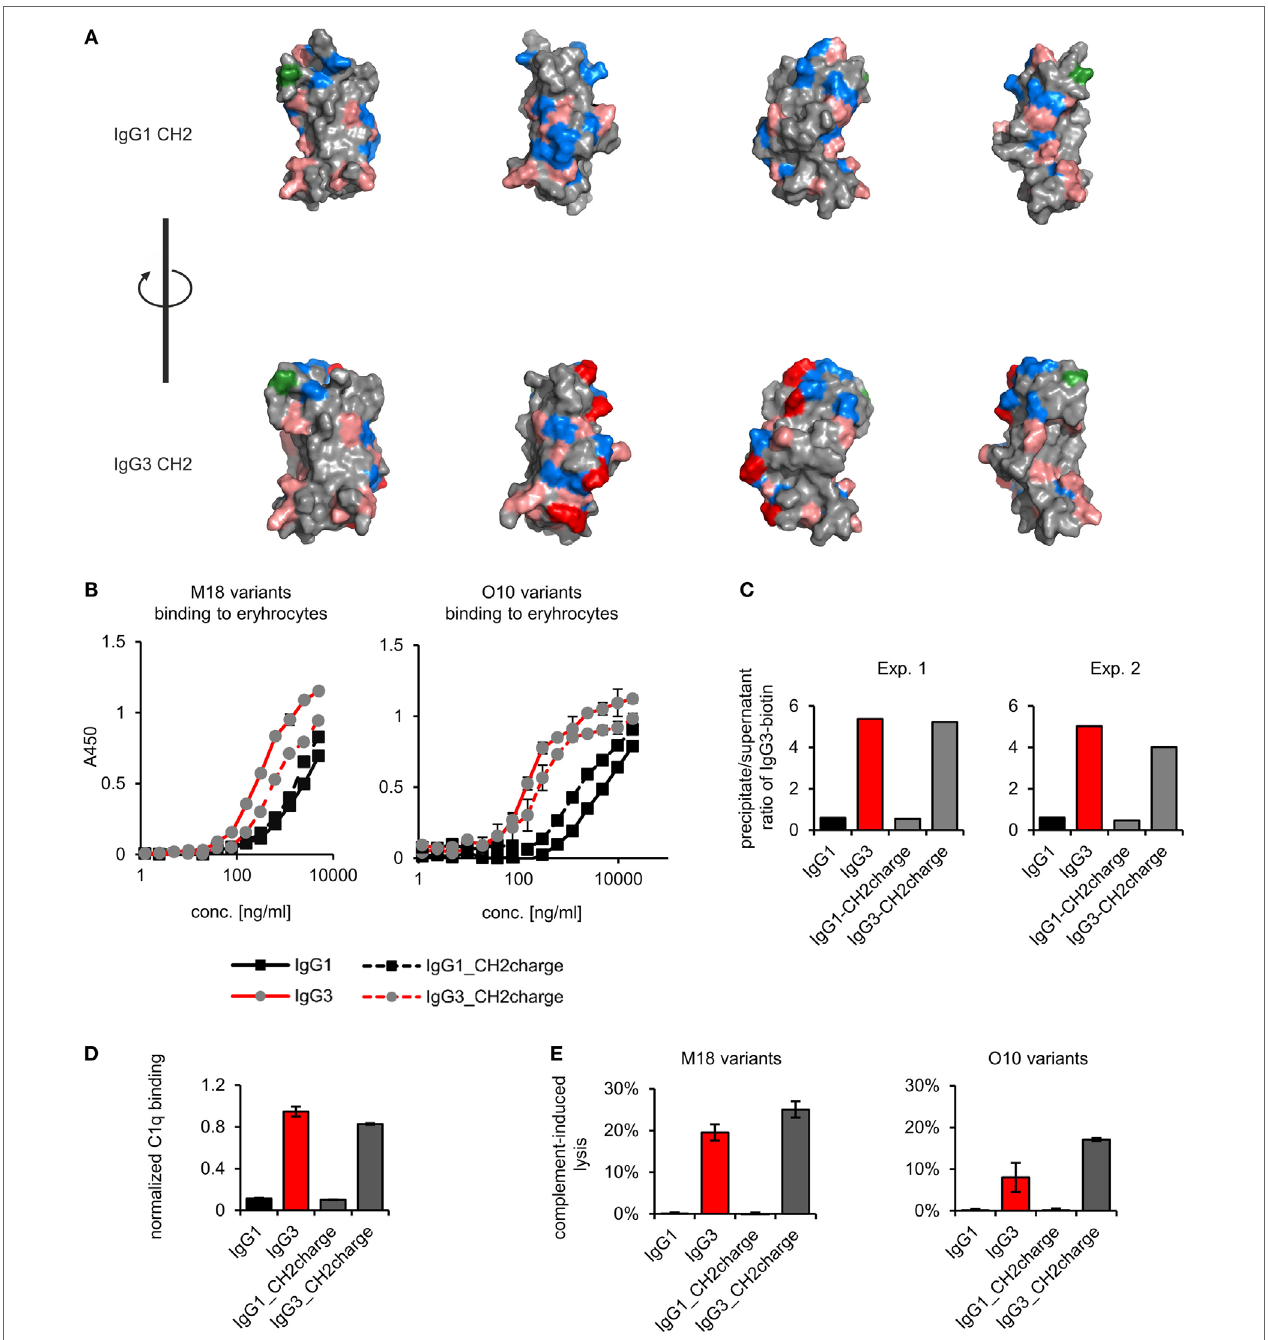
FigUre 7 | Properties of the muteins with modified charge of the CH2 domain. (a) Charge location on the CH2 domain of IgG1 and IgG3. Basic residues (Arg, His, and Lys) are faint red, acidic residues (Asp, Glu) are blue, and a site of CH2 N-glycosylation (Asn297) is green. His274, Lys282, Arg315, and Lys326 of IgG3 CH2 are dark red. These four residues were swapped between IgG1 and IgG3 to generate IgG1_CH2charge and IgG3_CH2charge muteins. The images present views obtained by 90° rotation of the domain models. (B) Antigen binding by the muteins. The charts present representative results of two independent experiments performed in duplicates or triplicates. Error bars equal to SD. (c) Oligomerization of the muteins. Results from two independent experiments with 100 µg/ml of the antibodies (M18 variants) are shown. A percentage of the total IgG3-biotin detected in precipitates and supernatants are presented in Figure S4 in Supplementary Material. Results for IgG1 and IgG3 are the same as in Figure 4 because the data were collected in the same experiments. (D) C1q binding by the muteins (O10 variants, 3 µg/ml). Data used for calculation of the normalized binding are shown in Figure S7 in Supplementary Material. The chart presents representative results of two independent experiments. Error bars correspond to uncertainty calculated as presented in Section “Materials and Methods.” (e) Complement cascade activation by the muteins (3 µg/ml). Erythrocytes coated with the antibodies were incubated with complement serum. Complete lysis (100%) corresponds to water-induced lysis. Representative results of two independent experiments are